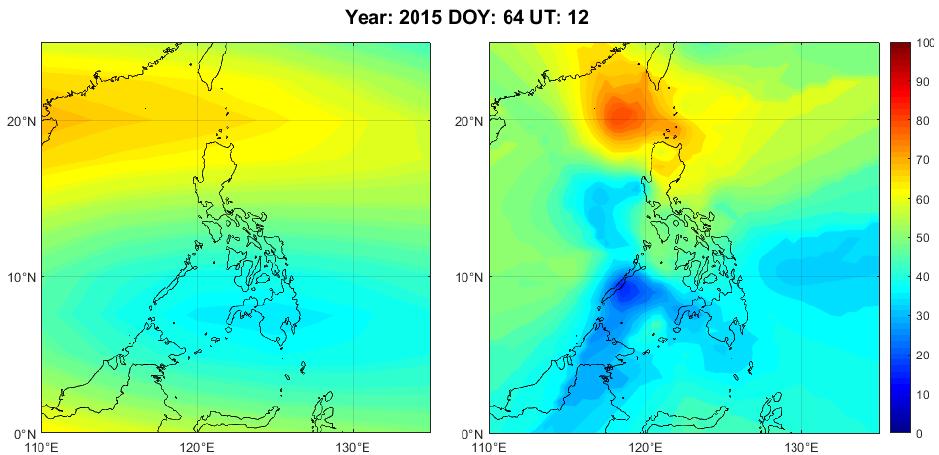
Figure 6. Comparing IGS GIM ( left ) and a VTEC map based on PAGeNet GNSS data and mapped using kriging interpolation ( right ).